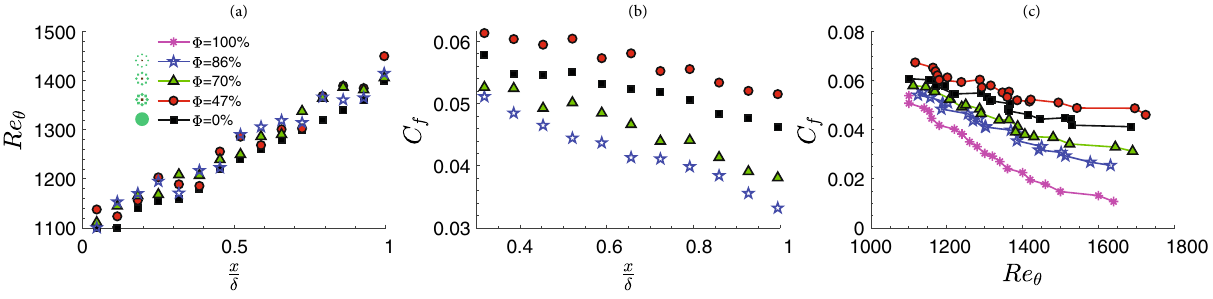
) dy ) in ( 1 − u u ∞ (cid:31)